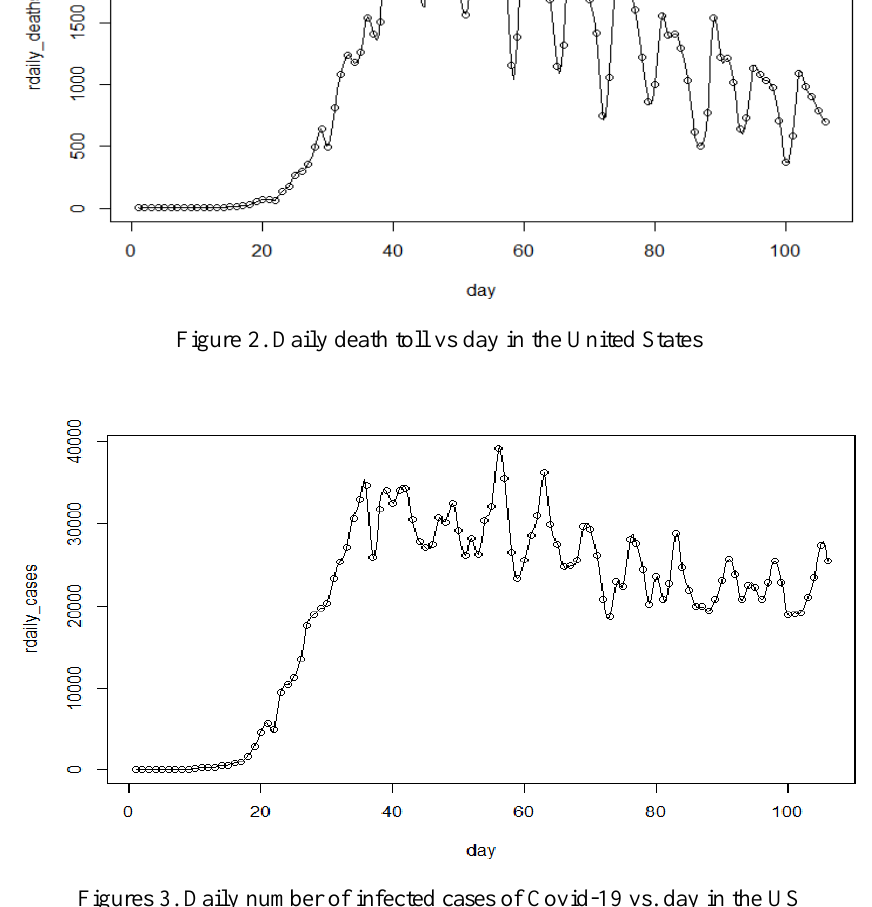
Figures 3. Daily number of infected cases of Covid-19 vs. day in the US Table 3. Model selection criteria based on available data in the United States S election